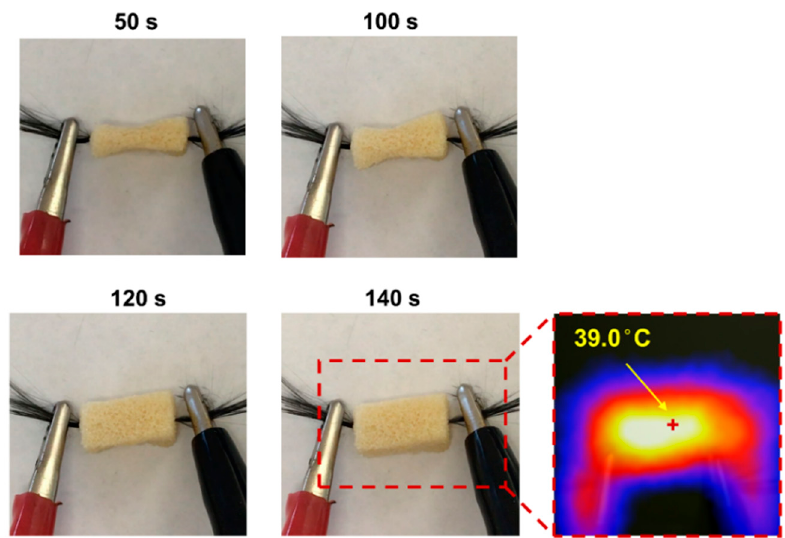
Figure 6. Experimental photos of the shape recovery process of the compressed SMP foam under 0.15 A DC, along with the measured surface temperature profile via an IR camera at 140 s after the applied electric current.